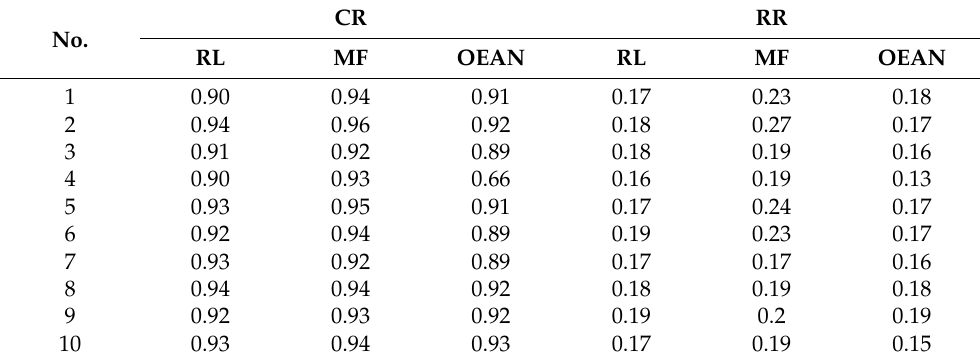
Table 2. Performance index of top-coal